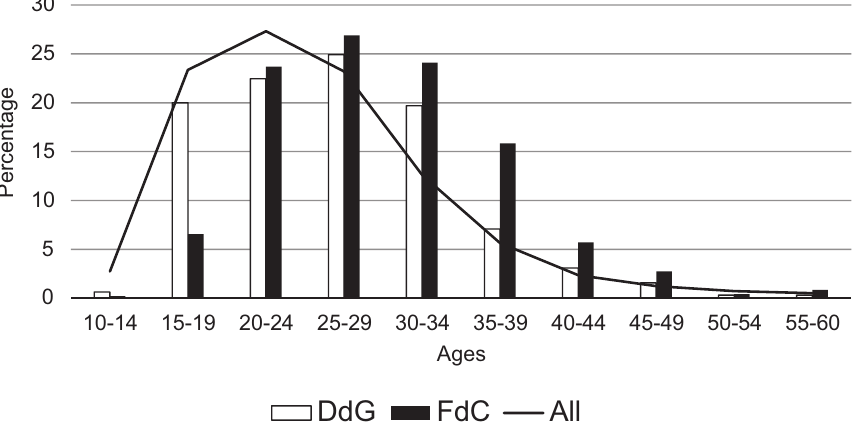
Figure 3 - Percentage of listeners according to age for the SC podcasts Dragões de Garagem (DdG, n = 325), Fronteiras da Ciência (FdC, n = 473), and the general mean for Brazilian podcasts (All, n = 16,197).